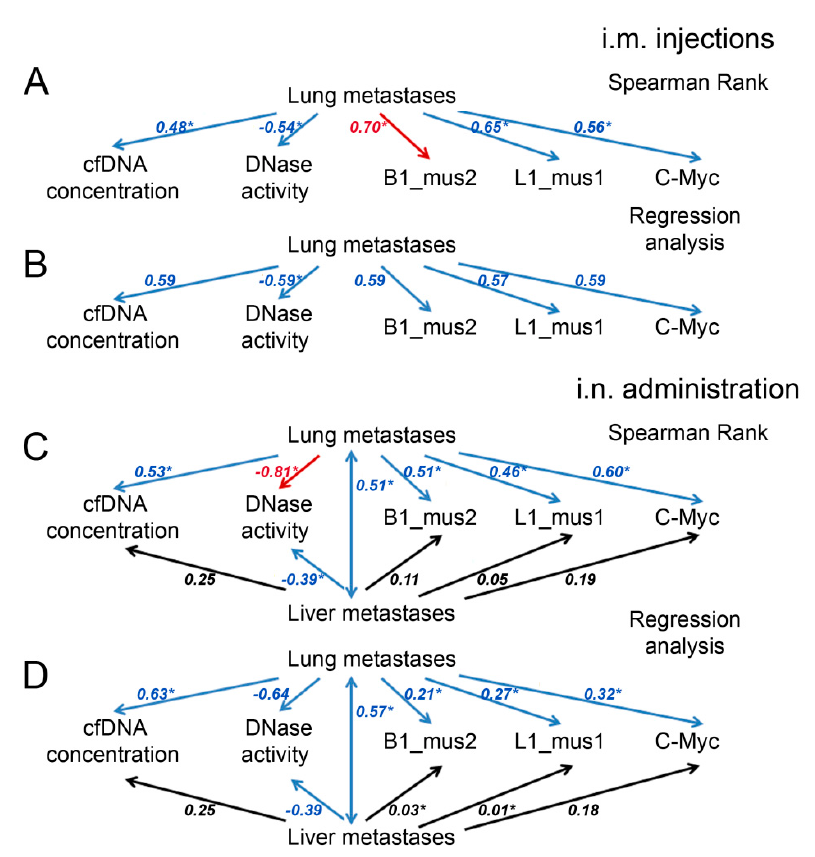
Figure 7. Correlations between the metastasis number, serum DNase activity, serum cfDNA concentration and B1_mus1, L1_mus1 and c-Myc levels in cfDNA. Correlation coefficients (Spearman rank, r, and regression analysis, R 2 ) reflecting the statistical relationships between the studied parameters were evaluated for mice with B16 after intramuscular ( A , B ) or intranasal ( C , D ) administration of saline buffer, DNase I or Pulmozyme ® . Red arrows indicate strong positive or negative correlations (0.70 ≤ r or R 2 ≤ 0.99), blue arrows indicate moderate correlations (0.3 ≤ r or R 2 < 0.7), black arrows indicate weak correlations (0.01 ≤ r or R 2 < 0.3); * indicated statistical significance p < 0.05.